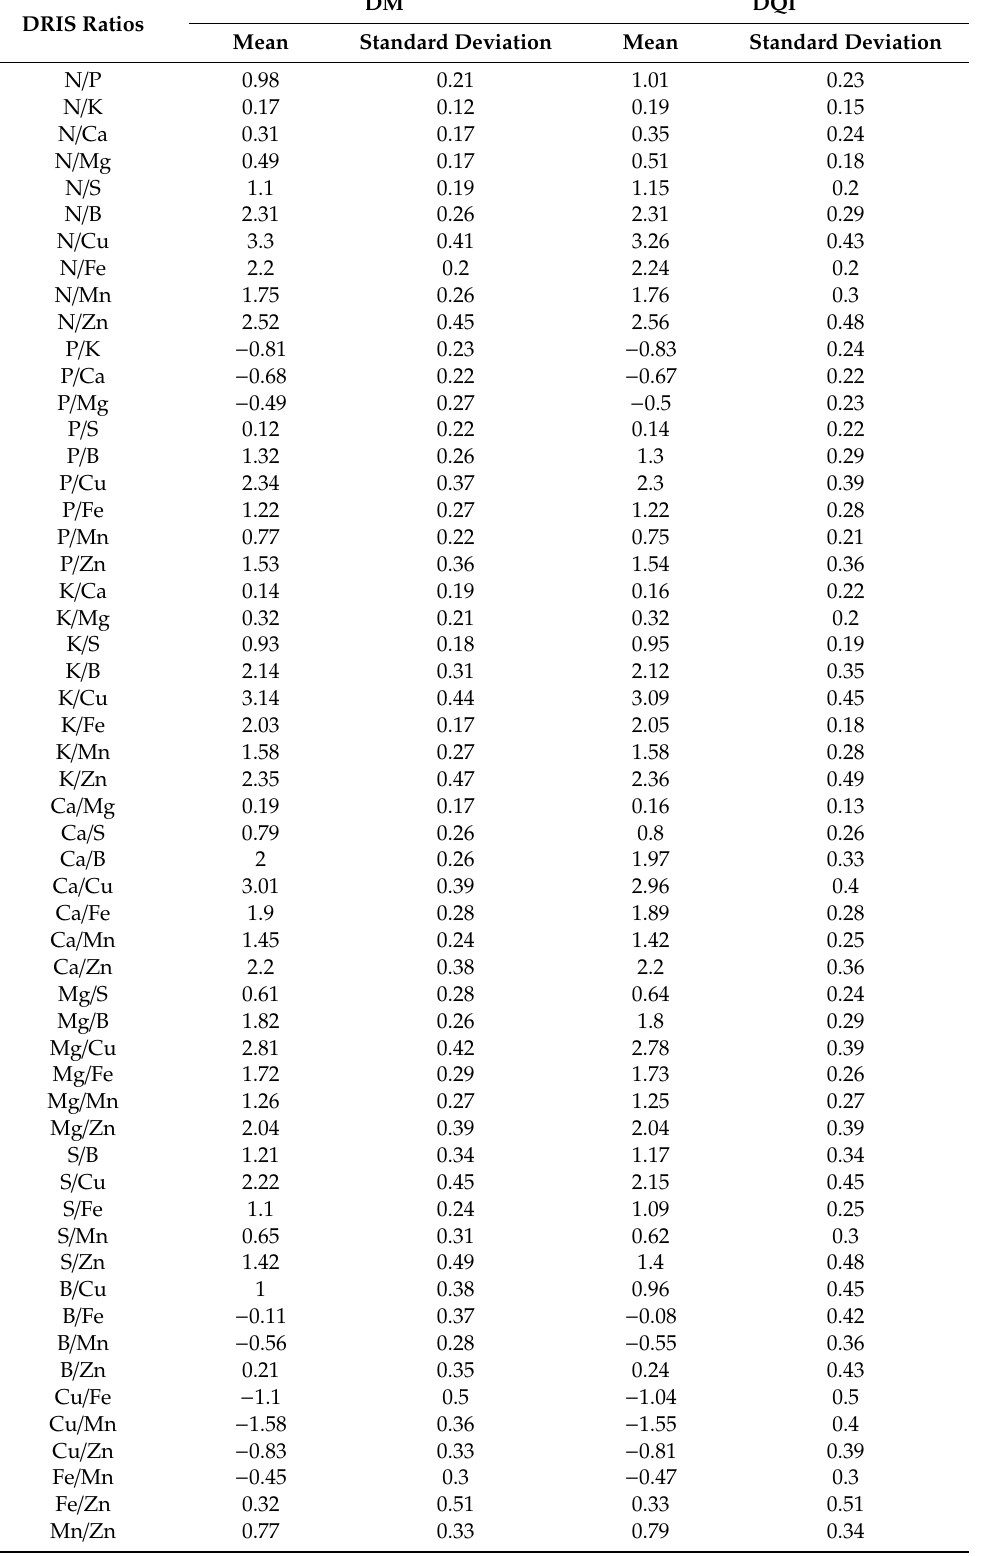
Table 4. DRIS guidelines log transformed for Eucalyptus spp. clonal rooted cuttings for the yield indicators whole plant dry matter (DM) and Dickson quality index